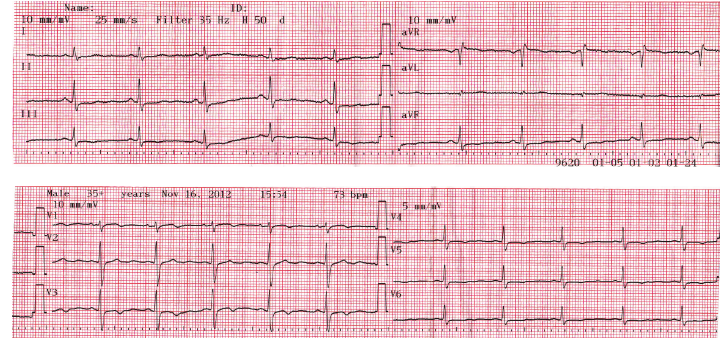
Figure 1: Twelve-lead electrocardiogram on admission shows long QT intervals and inverted T waves.